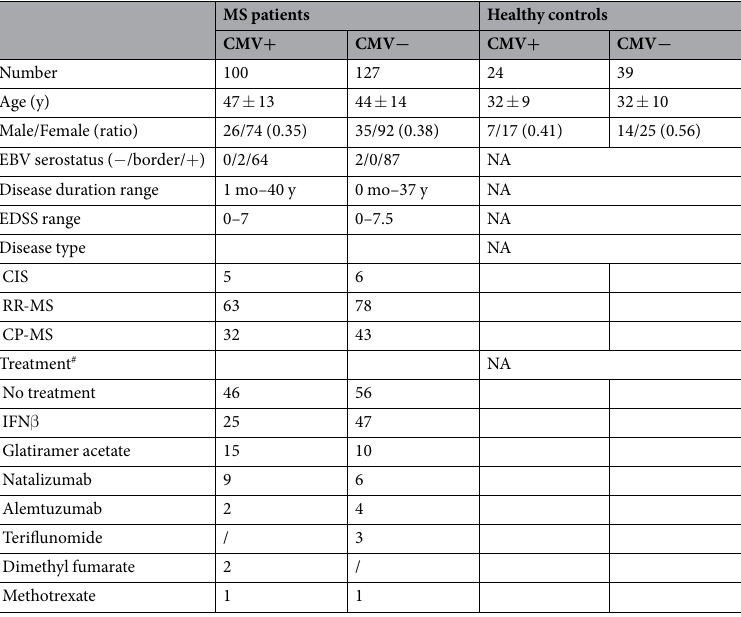
Table 1. Study subjects for CD4 + CD28 null T cell analysis. # Within 3 months before blood collection. MS, multiple sclerosis; EDSS, expanded disability status scale; CIS, clinically isolated syndrome; RR, relapsing remitting; CP, chronic progressive; IFN β , interferon beta; CMV, cytomegalovirus; NA, not